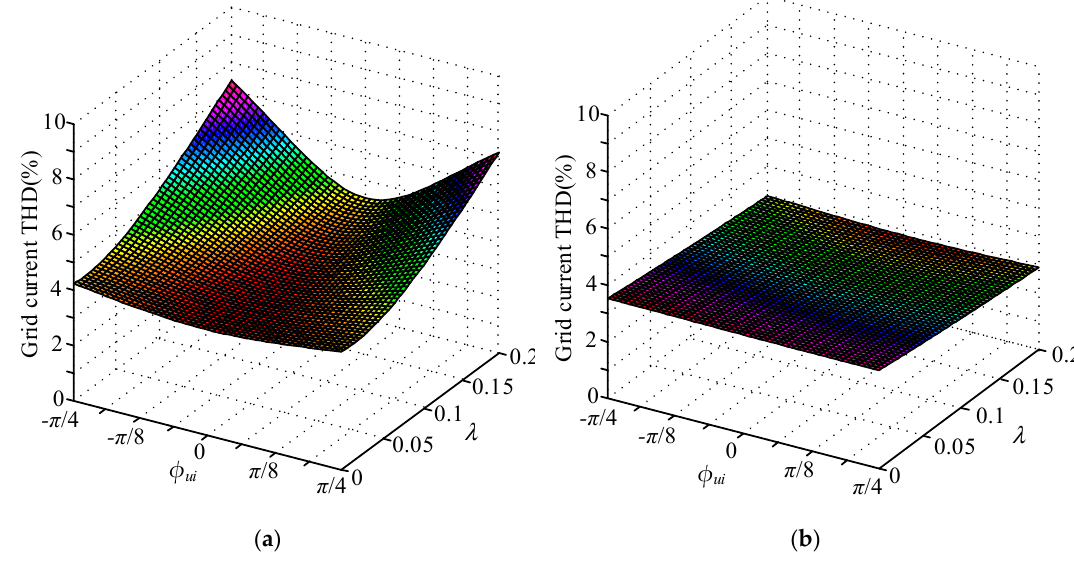
Figure 8. Surfaces of the THD results as the function with φ ui and λ : ( a ) Traditional SPWM; ( b ) DCR-SPWM.